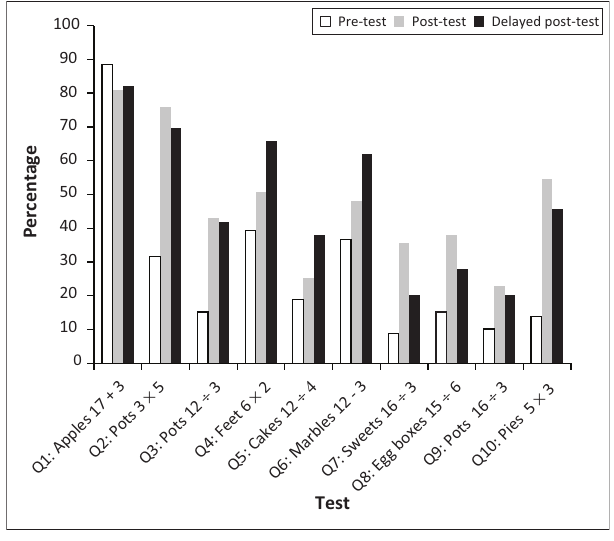
FIGURE 6: Grade 1 correct answers (percent), pre-, post- and delayed post-test ( n = 79).